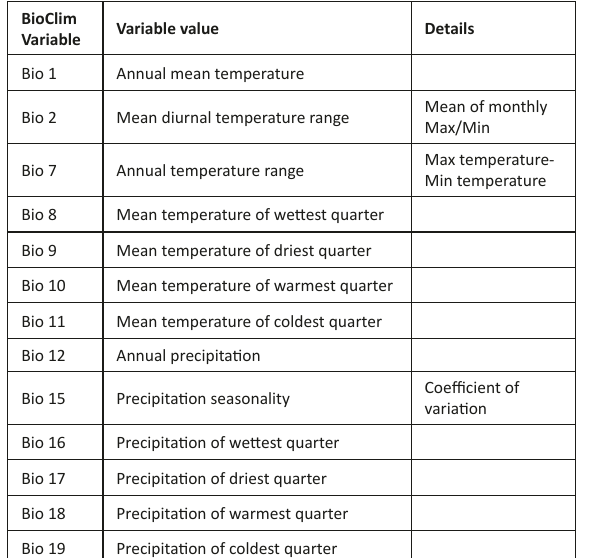
Table 3. Predicted extent of occurrence for Aotus spp. based on Rowe & Myers (2012).